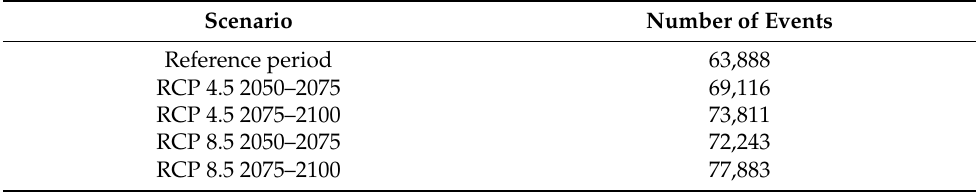
Table 1. Number of events per scenario: two time periods and two